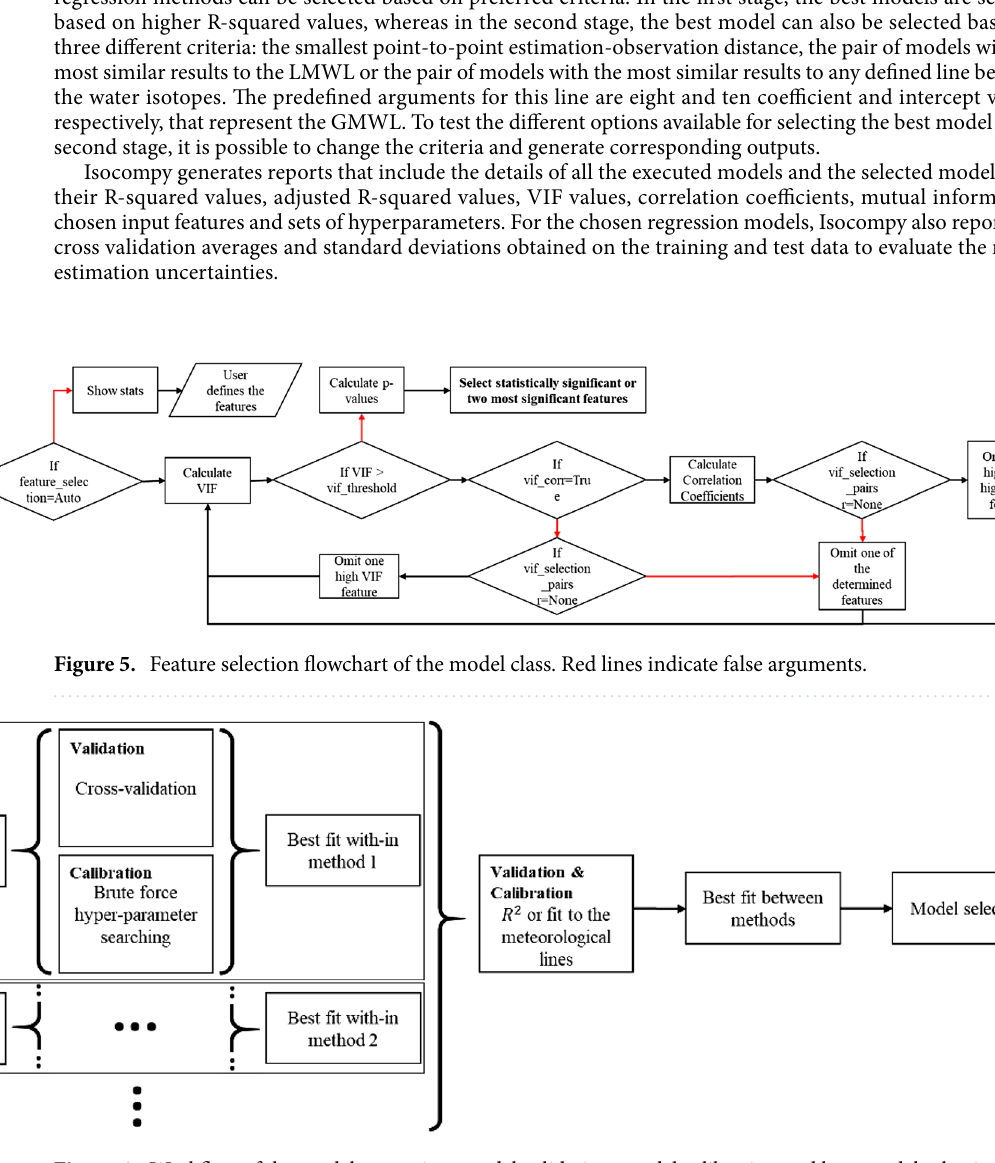
Figure 6. Workflow of the model regression, model validation, model calibration and best model selection processes. Black dots show that these processes are performed for each regression method